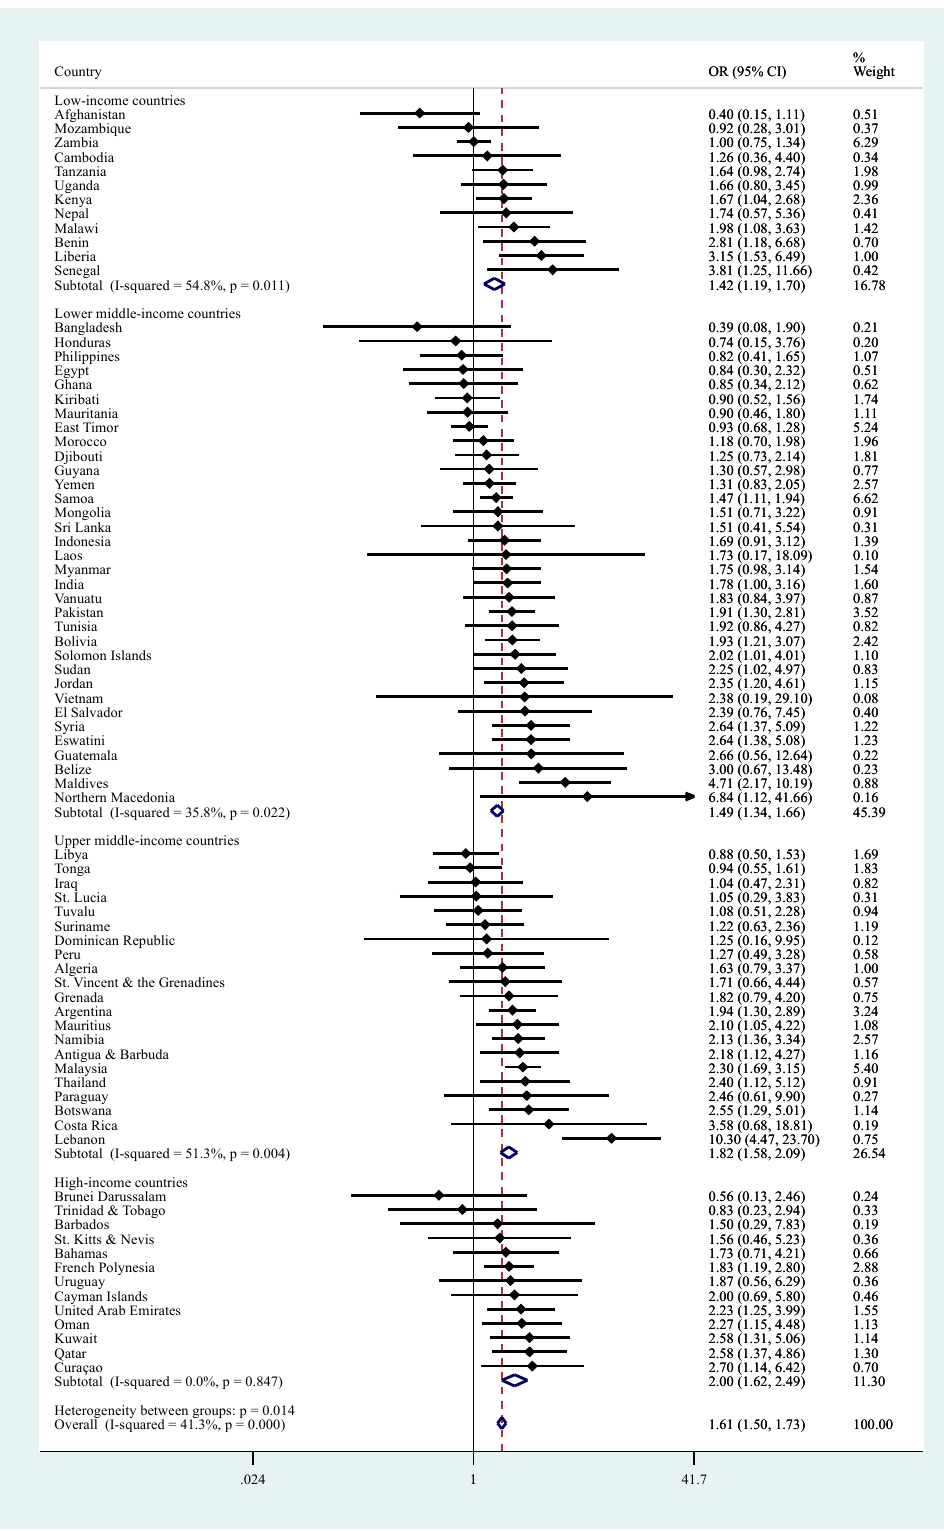
Figure A2. Country-wise association between severe food insecurity and never/rarely washing hands after using toilet estimated by multivariable logistic regression adjusted for age and sex; Abbreviation: OR Odds ratio; CI Confidence interval; overall estimates were calculated by meta-analysis with random effects.